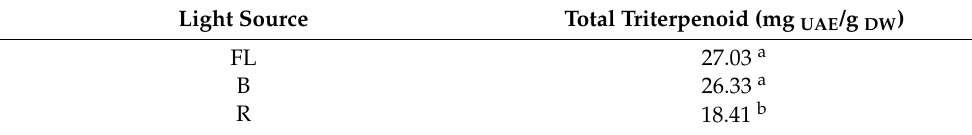
Table 3. Total triterpenoid content of H. corymbosa leaves after 4 weeks of growth under different light sources at the same light intensity of 50 µ mol · m − 2 · s − 1